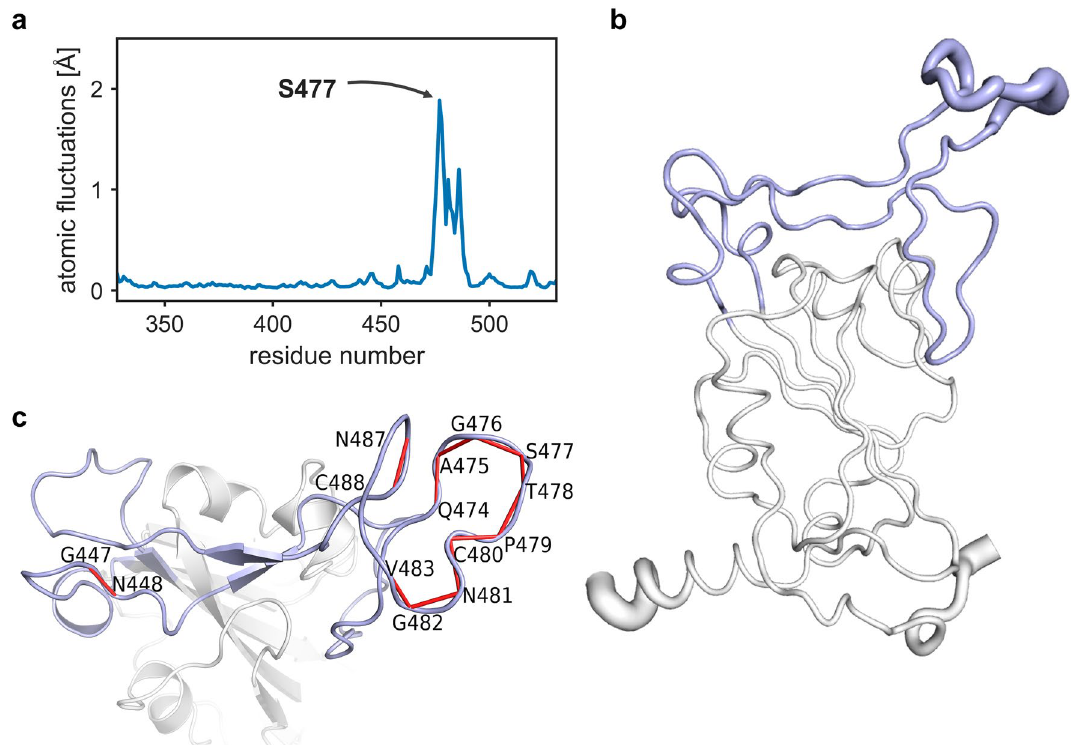
Figure 2. DynaMut flexibility analysis performed over the first 10 non-trivial modes of the molecule. ( a ) Residue wise atomic fluctuations in RBD. ( b ) Structure of the RBD in a ‘sausage-style’ representation with the thickness of the tube indicating the magnitude of the fluctuations. The RBM is shown in light blue. ( c ) Annotation of dynamical cross correlations among residues of the RBD, with the RBM again shown in light blue. Only the highly correlated pairs of residues with a correlation coefficient of (≥ 0.9) are annotated and connected by red lines.